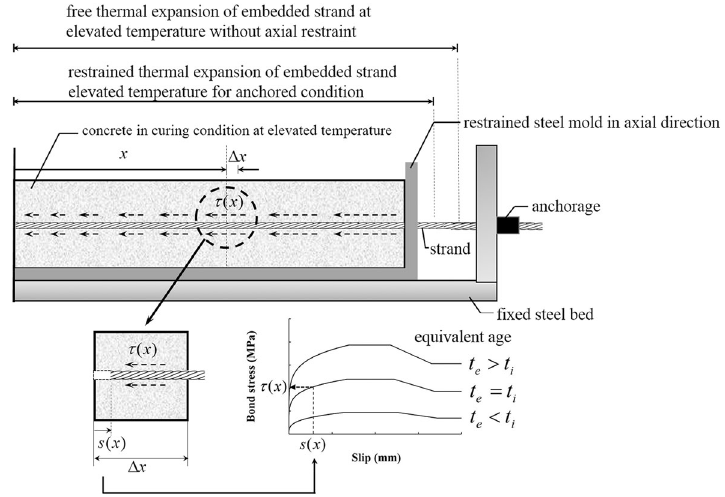
Fig. 1 Bond stress and slip developed at t e = t i